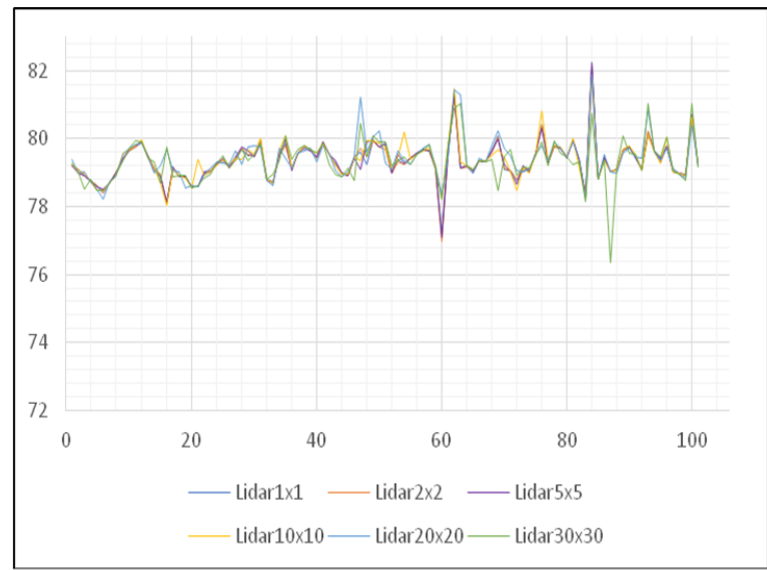
Figure 11. Movement of corrected values of height of DEM of the Center area.